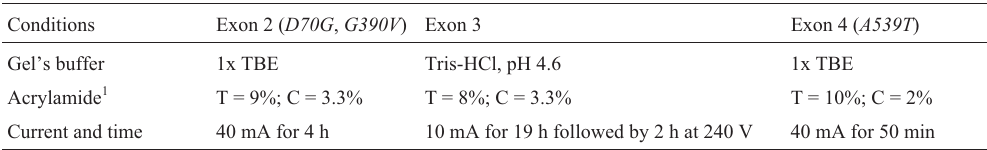
Table 1 - Electrophoresis conditions for the amplified products of the human butyrylcholinesterase BCHE gene. The electrophoresis buffer was 1x tris-borate-EDTA (TBE).